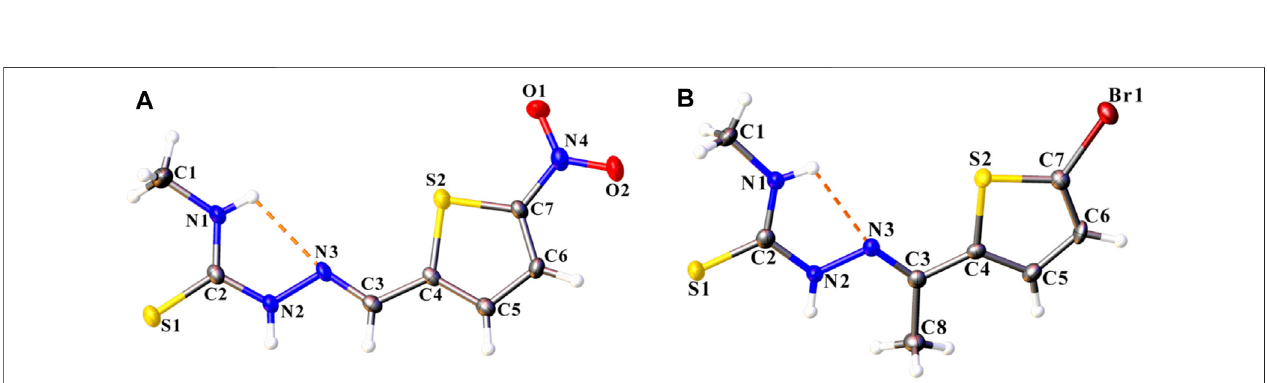
FIGURE 1 | The molecular structure of compounds (A) L1 and (B) L2, with displacement ellipsoids drawn at the 50% probability level. The intramolecular N – H ··· N hydrogen bond is shown as orange dashed lines. H atoms are represented as small spheres of arbitrary radii.